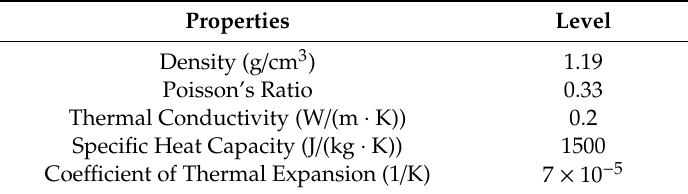
Table 1. The properties of polymethylmethacrylate (PMMA; Chimei CM-205).